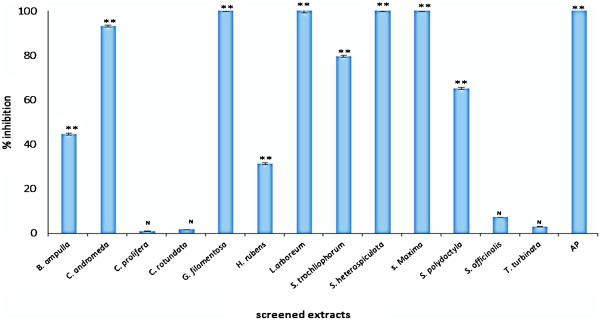
HIV-1 PR inhibition percentages of different marine extracts. Samples were dissolved in DMSO and diluted with the assay buffer to a final concentration of 100 μg/ml. Significant differences between the extracts and the DMSO control was calculated using IBM SPPS version 19. **P < 0.00, *P < 0.05 and N indicates not significant. AP indicates the experimental positive control acetyl pepstatin.